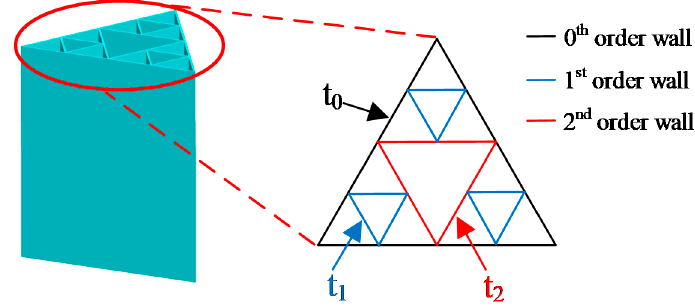
Figure 11. Illustration of the thickness of different level walls.